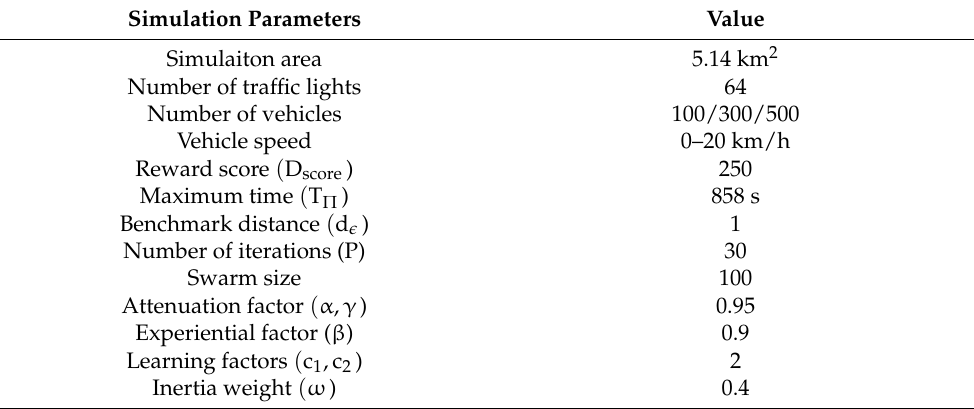
Table 2. The detailed simulation